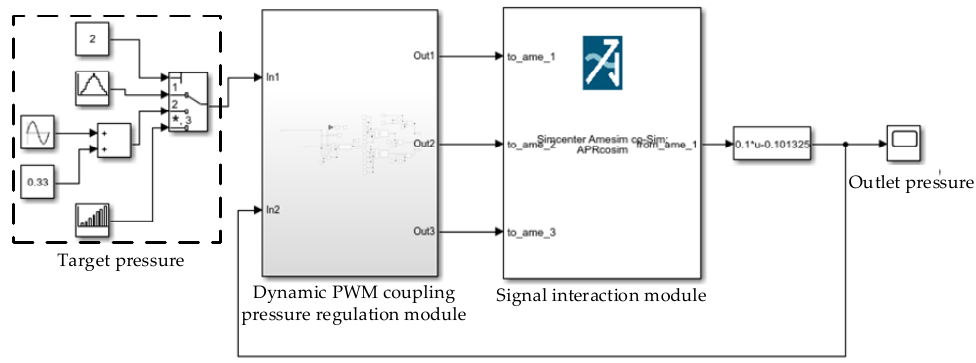
Figure 5. The control part of the co-simulation model. According to research on the LF-APRV in the ECPBS in commercial vehicles, the parameters of the co-simulation model are shown in Table